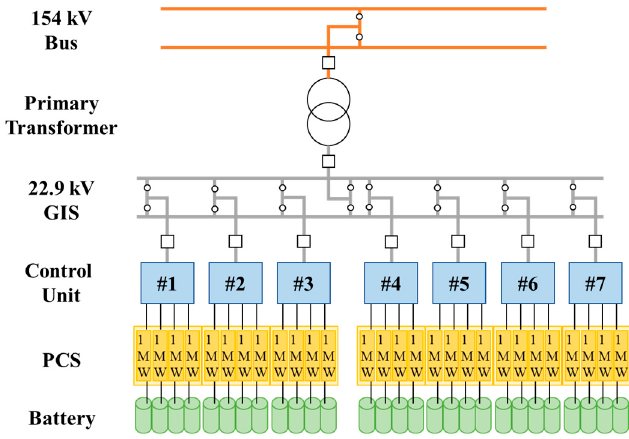
Figure 2. The typical configuration of BESS based on a single substation.